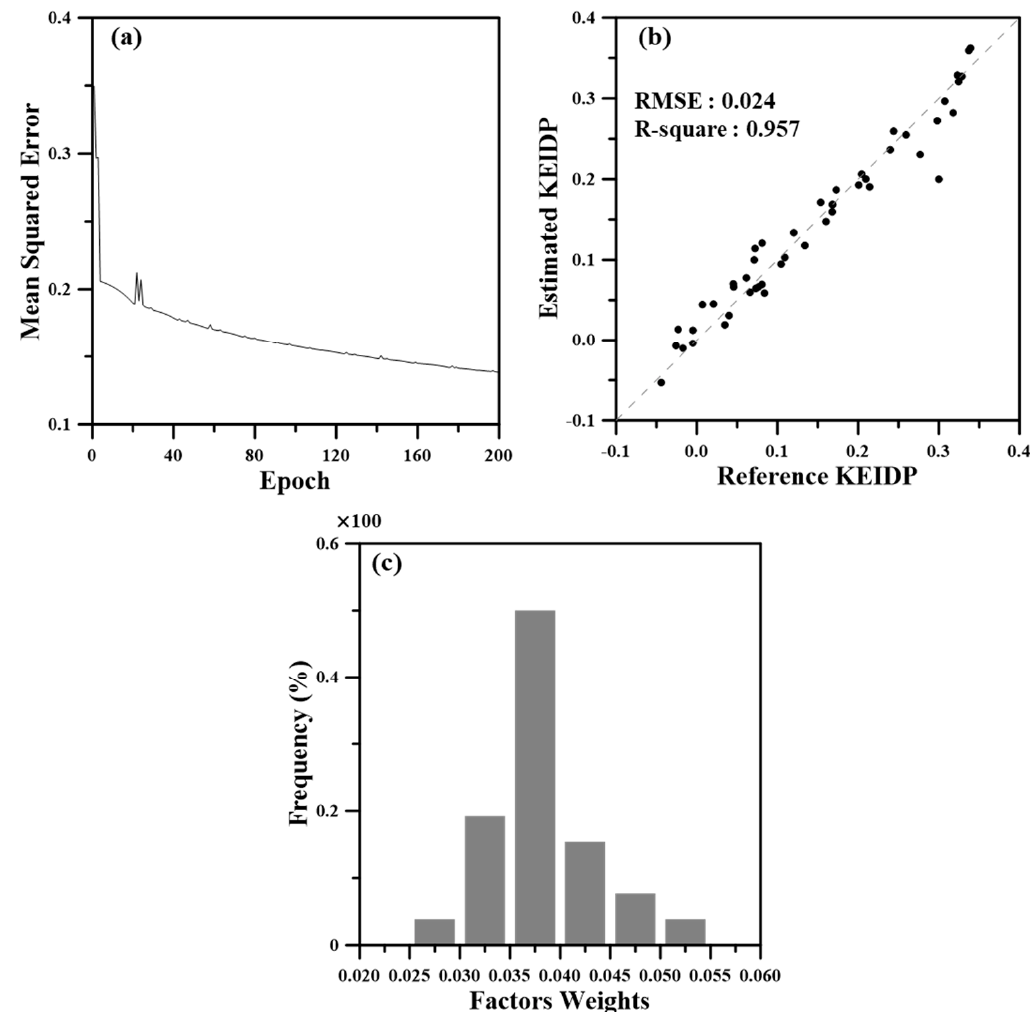
Figure 3. Error convergence, validation and distribution of factors weights results of produced MLP based ANN model: ( a ) error convergence graph; ( b ) model validation graph; ( c ) distribution of factor weightings.